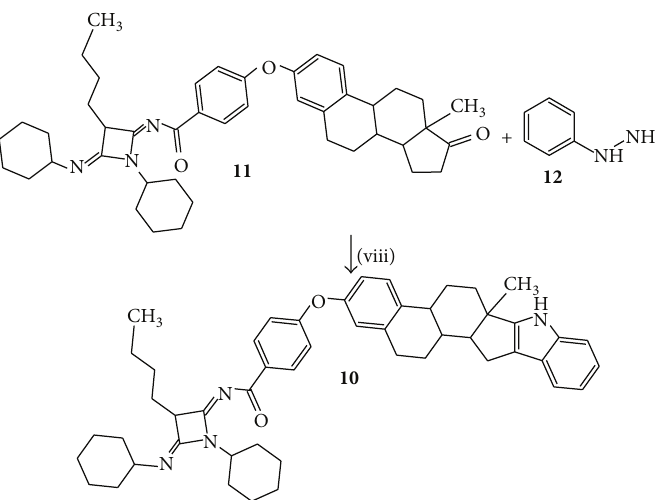
Figure 6: Synthesis of 3-[4-(2-butyl-3-cyclohexylimino-4-piperidin-1-yl-cyclobutylidencarbamoyl)]-phenoxy-NH-indolo[2 󸀠 ,3 󸀠 :17,16]estra- 1,3,5(10)triene ( 10 ). Reaction of 11 with phenylhydrazine hydrochloride ( 12 ) to form the compound 10 . (viii) = acetic